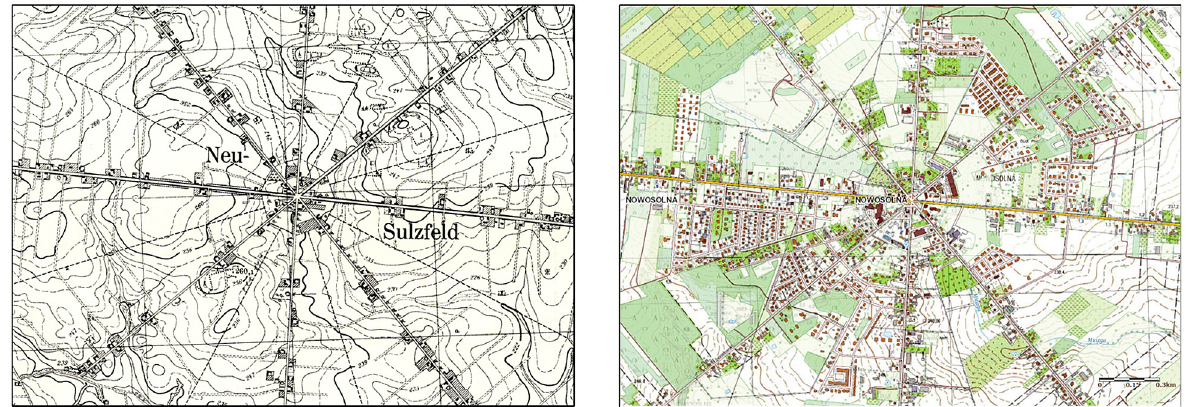
Fig. 4. Morphological changes in the former village of Nowosolna.